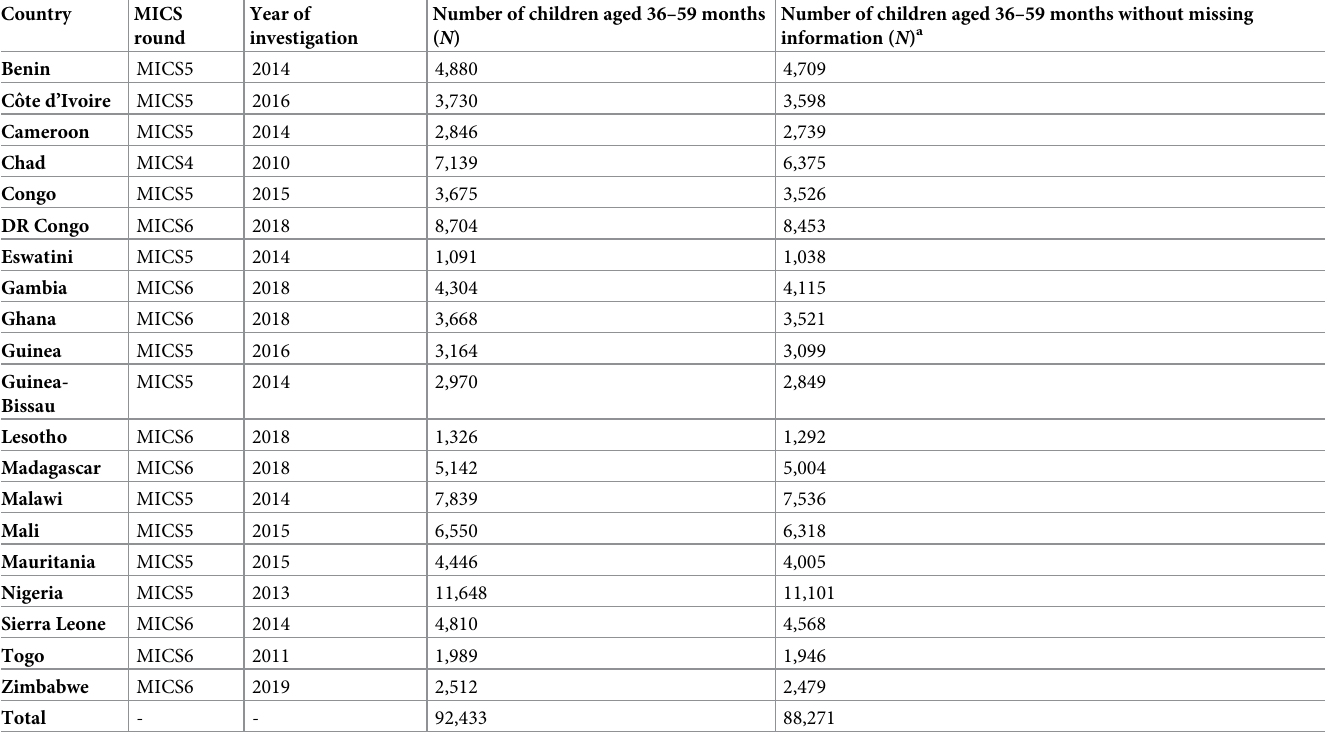
Table 1. Survey characteristics of the 20 countries included in the